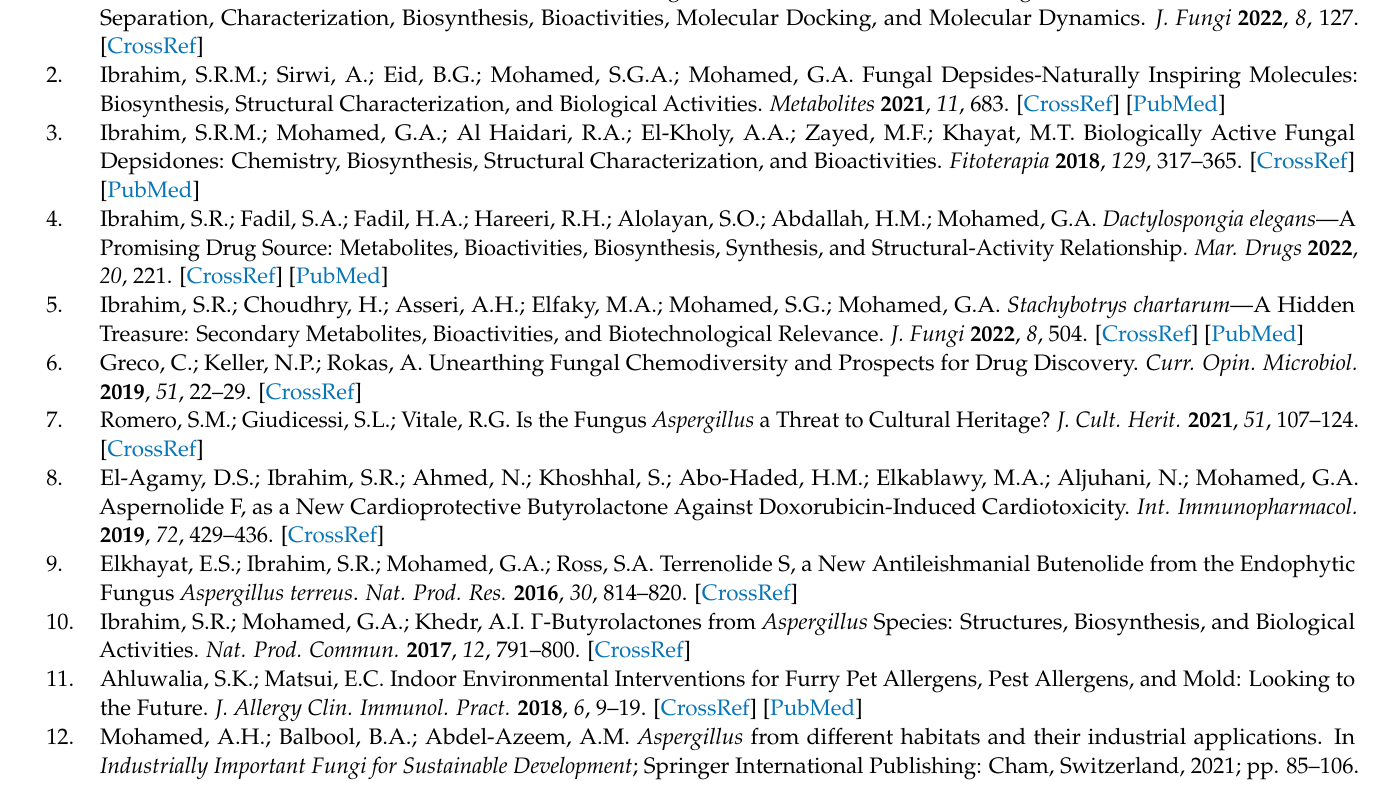
lines; PC-3: human prostatic-testosterone-independent cell line; ROS: reactive oxygen species; RP-18: reversed phase-18; SH-SY5Y: thrice-cloned subline of the neuroblastoma cell line; SRB: sulforho- damine B; SiO 2 CC: silica gel column chromatography; SKBR-3: human breast estradiol-independent cancer cell line; SMMC-7721: human hepatoma cell line; SMP: submitochondrial particles; SPA: scintillation proximity assay; SPC-A1: human lung cancer cell line overexpressing maspin cell line; SW1990: human pancreatic cancer cell line; TLC: thin layer chromatography; TNF- α : rumor necrosis factor alpha; Trolox: 6-Hydroxy-2,5,7,8-tetramethylchroman-2-carboxylic acid; U87: glioblastoma cell line; U251: glioblastoma cell line; U937: pro-monocytic, human myeloid leukaemia cell line; XRD: X-ray